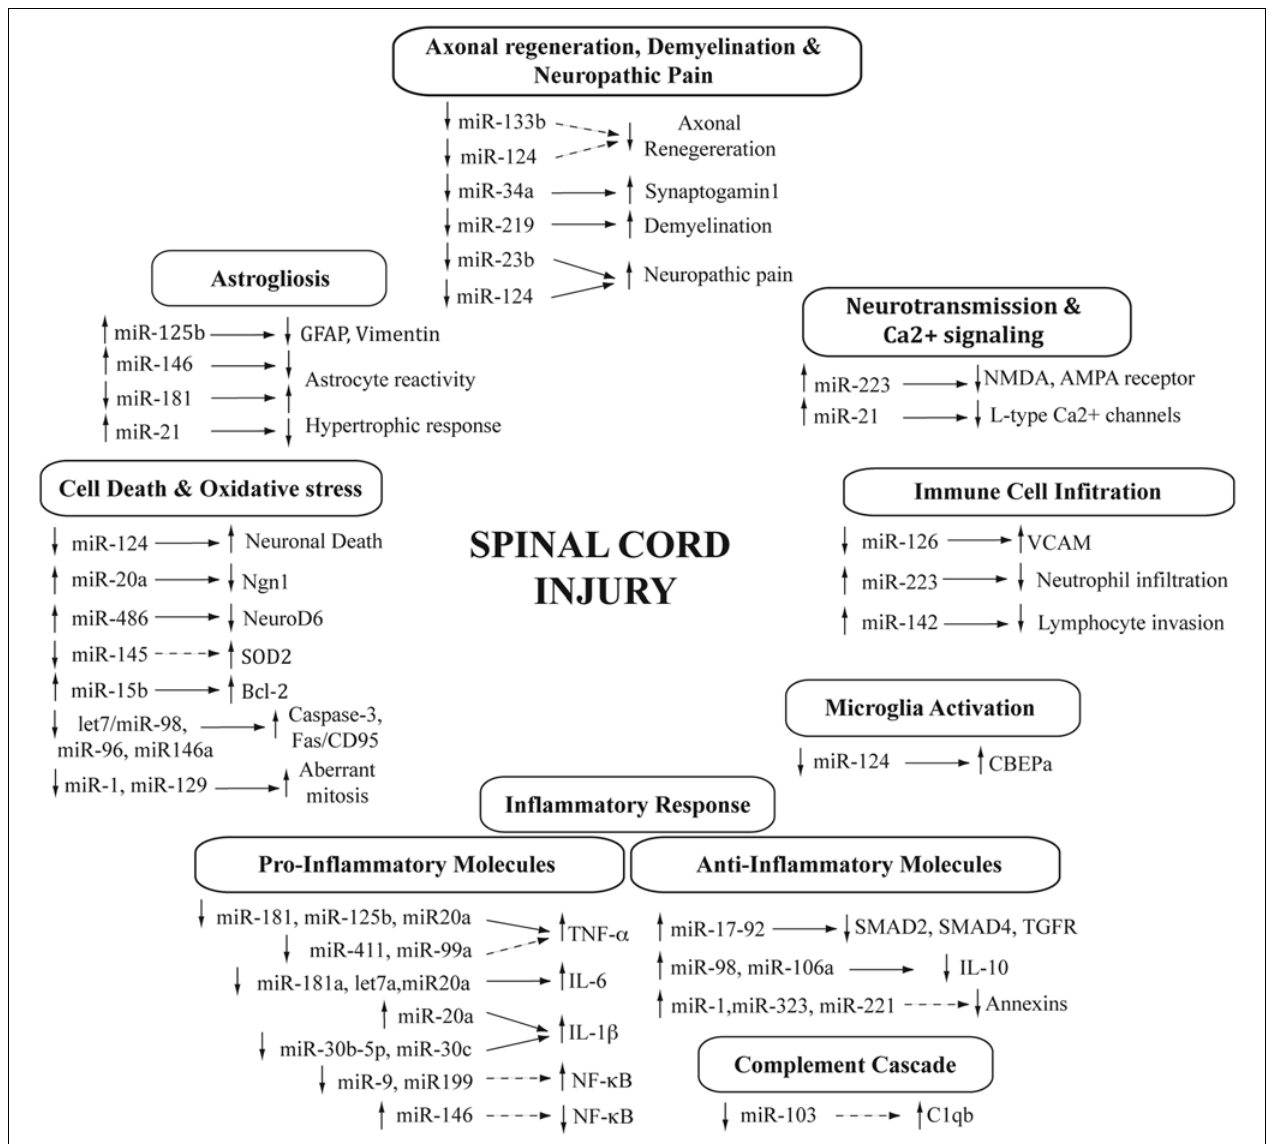
decreased (down arrow) after SCI. Target genes are also shown (confirmed, direct regulation are indicated with a solid arrow, whereas those indirect or predicted are represented with a dashed